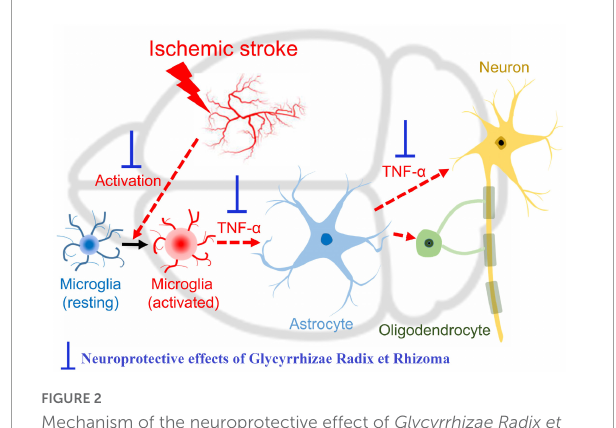
FIGURE2 Mechanism of the neuroprotective effect of Glycyrrhizae Radix et Rhizoma in the alleviation of inflammation in ischemia/reperfusion-induced brain damage (Choi et al.,